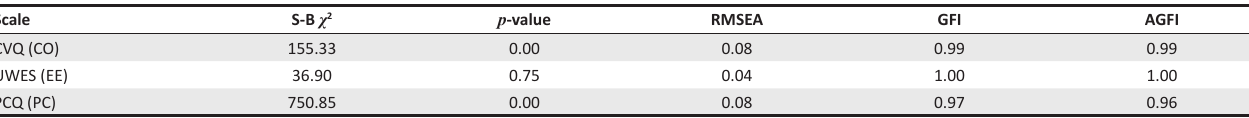
TABLE 4: Goodness-of-fit statistics of the measurement models of each multidimensional instrument. Scale